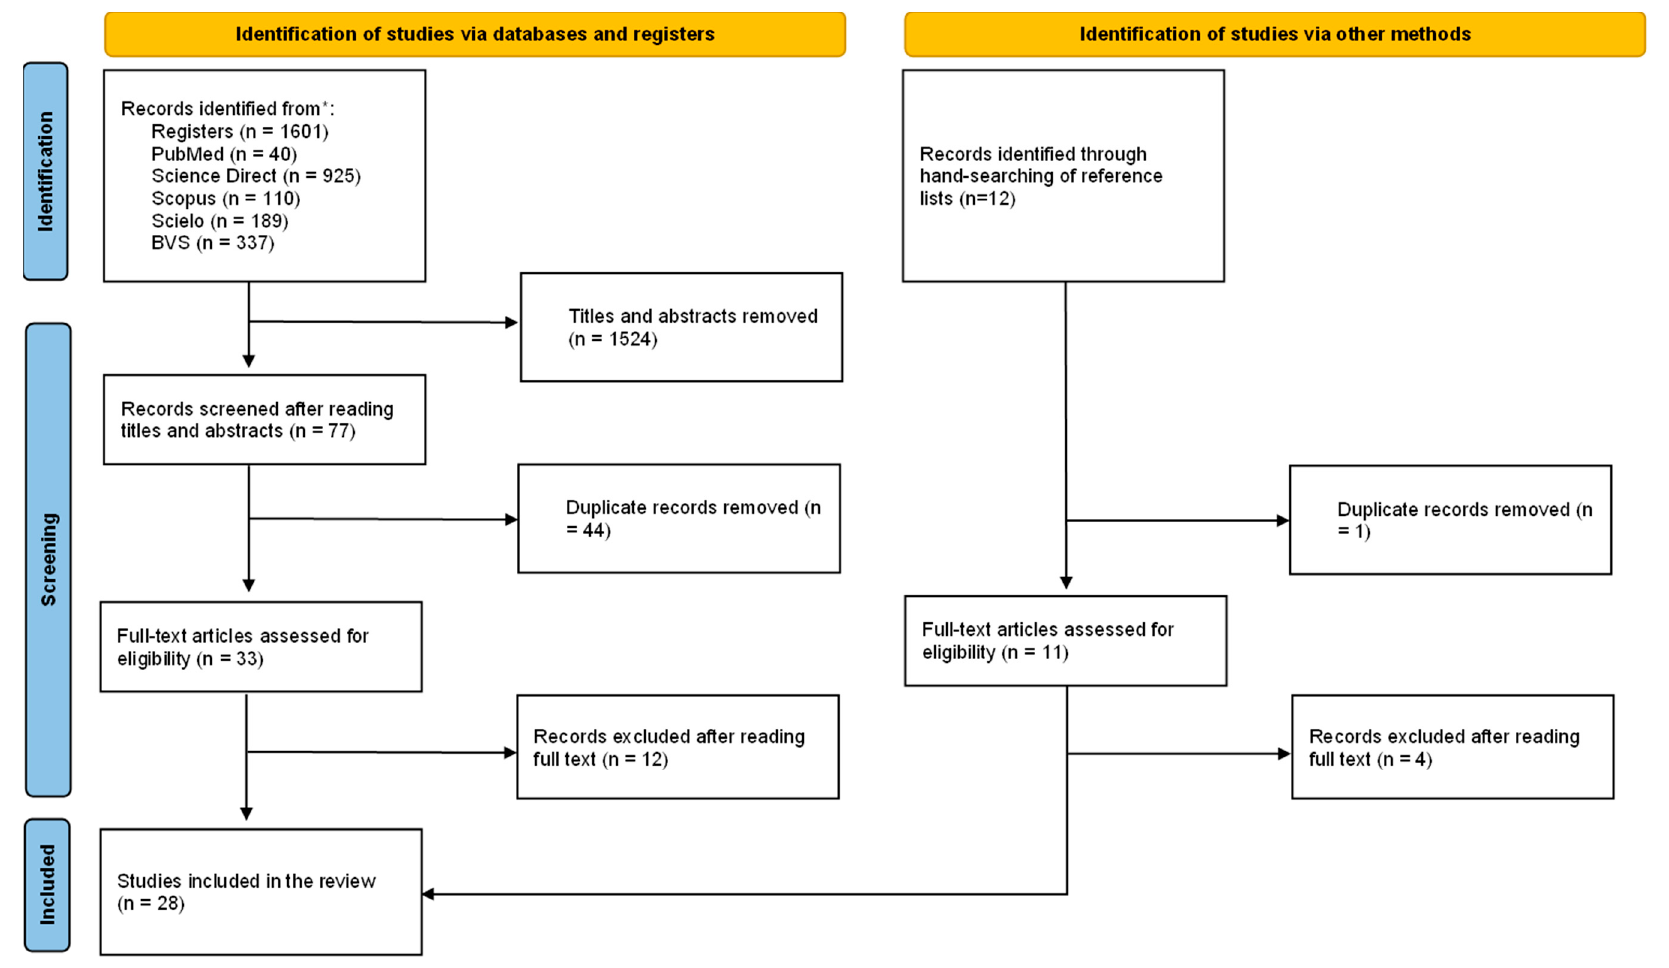
Figure 1. Flow diagram systematic search and review process. * Reporting the number of records identified from each database. Table 1. Reporting survival analyses of the included studies.